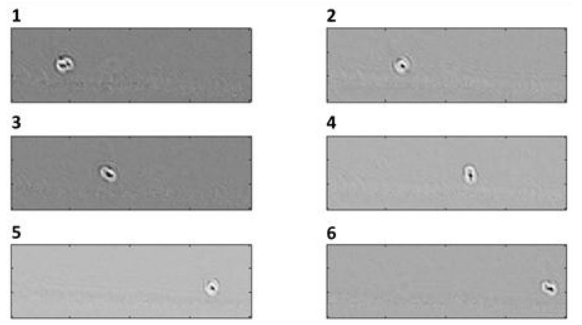
Figure 10. Out-of-plane rotation device. In the six consecutive frames, a cell close to the bottom of the channel is induced in rotation.